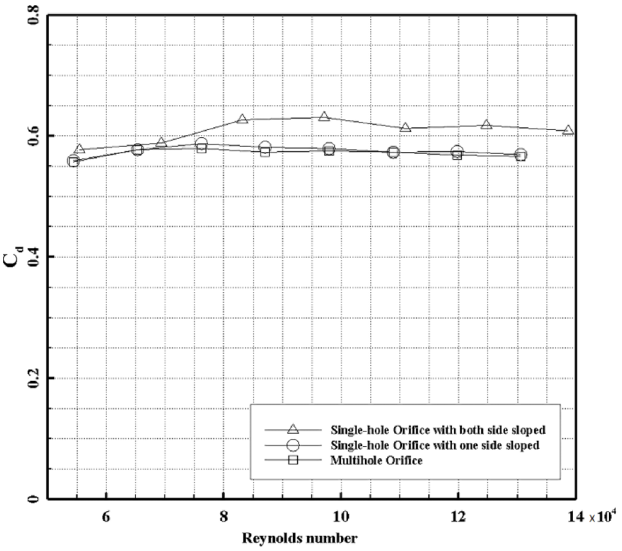
Fig. 12. Comparison of the trends of the discharge coef fi cient against the Rein a multi-hole ori fi ce, a single ­ -hole ori fi ce with a two-sided sloped edge and a single-hole ori fi ce with a one-sided sloped